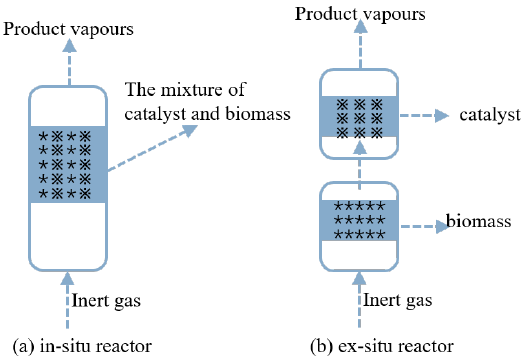
Figure 4. Schematic diagram of two catalysis modes in catalytic fast pyrolysis of biomass: ( a ) in-situ, and ( b ) ex-situ.